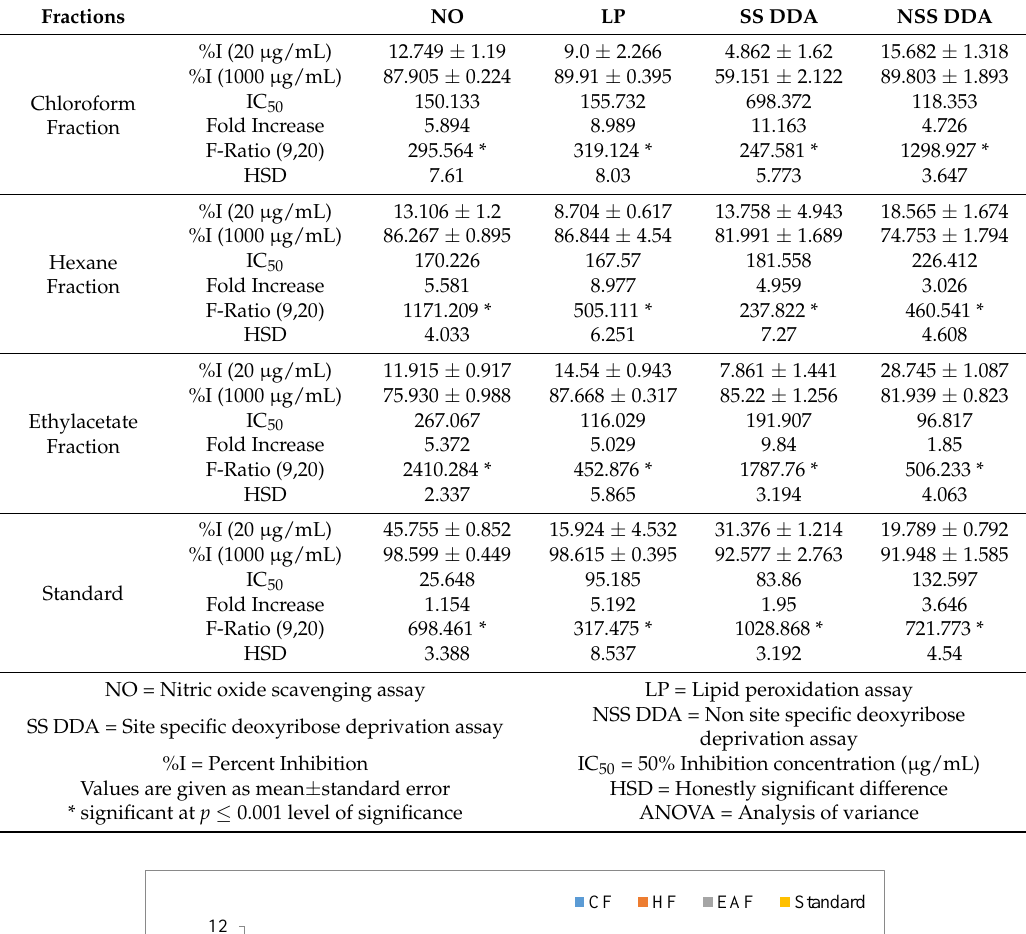
Table 1. Percent Inhibition, IC 50 fold increase activity, one-way ANOVA F-ratio and HSD value of different fractions in antioxidant assays.